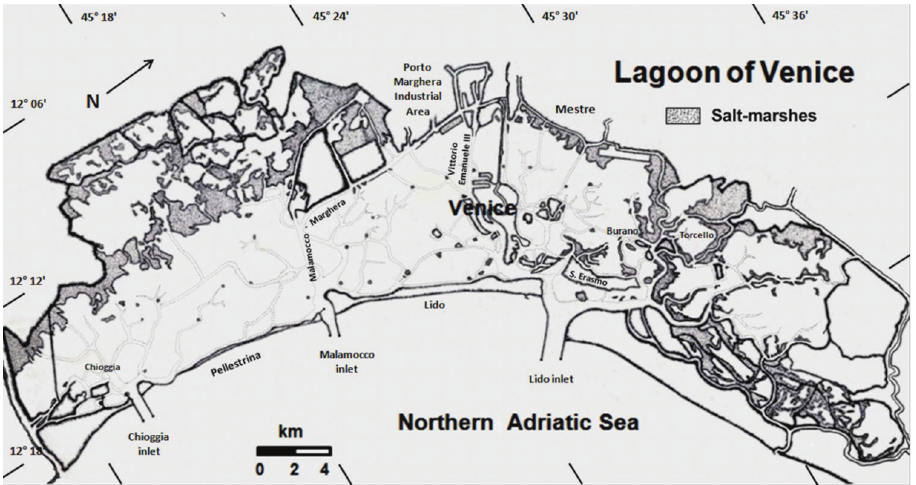
Figure 1. Map of the Venice